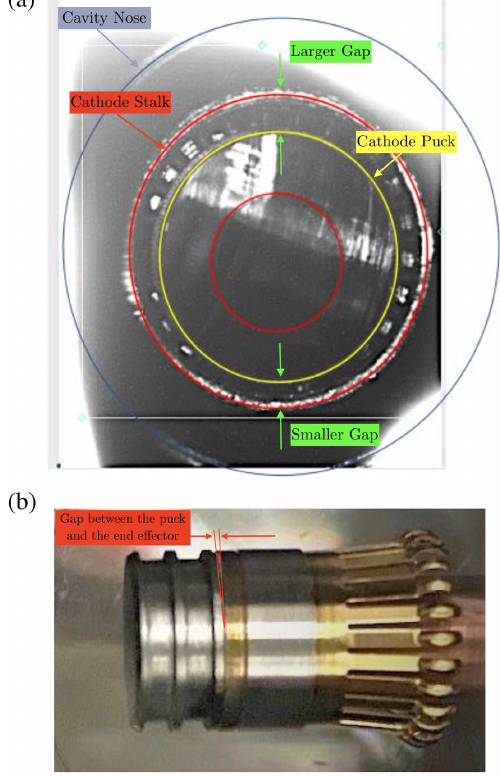
FIG. 5. (a) Cathode installed at the end of the cathode stalk. An asymmetric circular pattern can be seen here. (b) After the cathode was extracted from the gun, this image shows a gap that had opened up between the puck and the end effector.